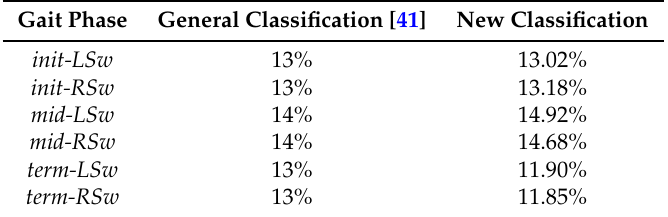
Table 5. The average swing phase percentage comparisons of the general classification and the new method. init, initial; LSw, left swing phase; RSw, right swing phase; term, terminal.